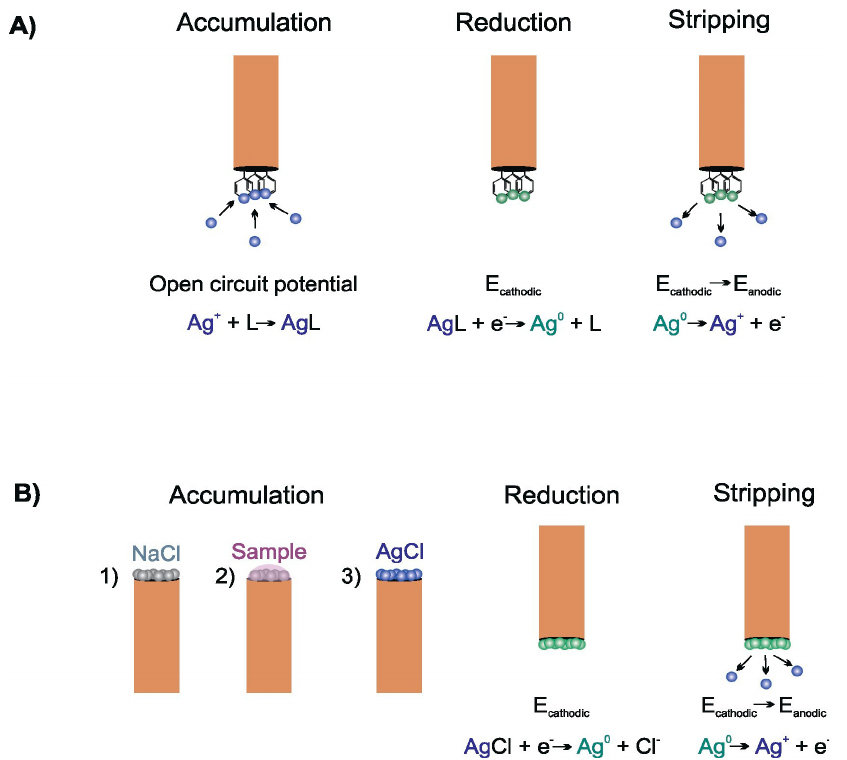
Figure 3. The graphical depiction of two sophisticated procedures for stripping voltammetry trace determination of Ag + ions based on data given in paper [1]. ( A ) Accumulation with ligand silver bond; ( B ) stripping voltammetry using microprobe.